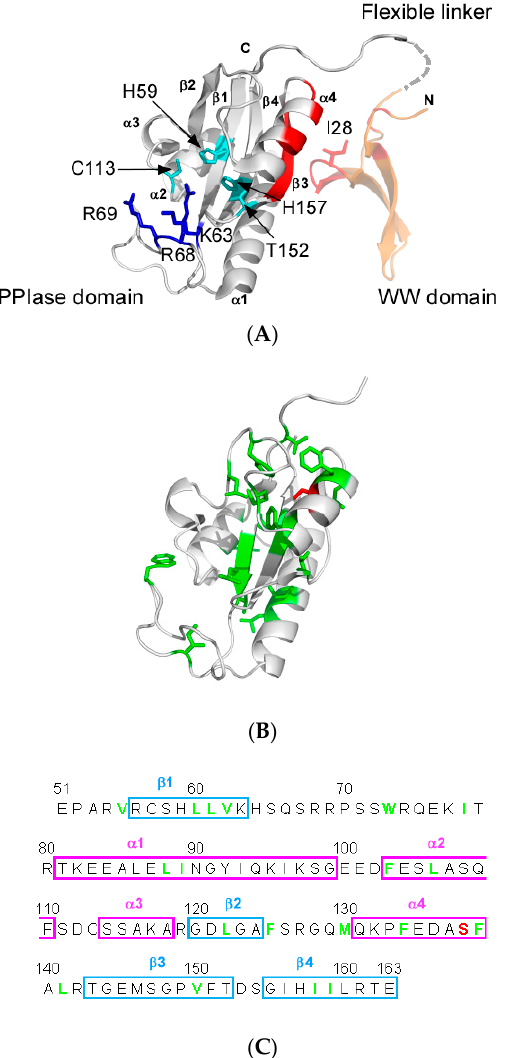
Figure 1. Structural features of the human Pin1 (Protein Data Bank (PDB) ID: 1PIN [11]). ( A ) Ribbon representation of the full-length Pin1 is shown. The Pin1-WW domain and the flexible linker are shown as the orange ribbon and as the dashed grey line, respectively (right-hand side). The Pin1-peptidyl-prolyl isomerase (PPIase) domain is colored grey (left-hand side). Residues involved in the central hydrogen-bonding network and in the phosphate moiety binding ‘basic triad’ are shown as cyan and blue sticks, respectively. I28 in the WW domain is also shown in stick model representation. Residues at the interdomain interface are colored red; ( B ) Solution structure of the wild-type PPIase domain [13]. The hydrophobic conduit residues and S138 are show as green and red sticks, respectively. The orientation is the same as in ( A ); ( C ) The amino acid sequence of the Pin1-PPIase domain. The positions of the α helices and β strands in the sequence are indicated by the magenta and cyan boxes, respectively. The conserved hydrophobic residues estimated by Behrsin et al. [16] are shown as green bold letters and S138 is shown as a red bold letter.